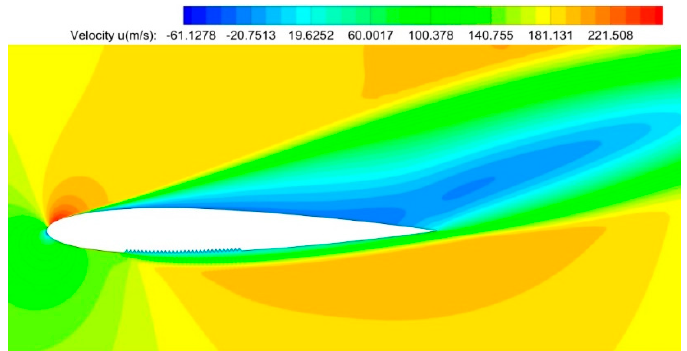
Figure 25. t = 1 s, velocity distribution of NACA0012 airfoil with grooves on the suction side at a 19° angle of attack.